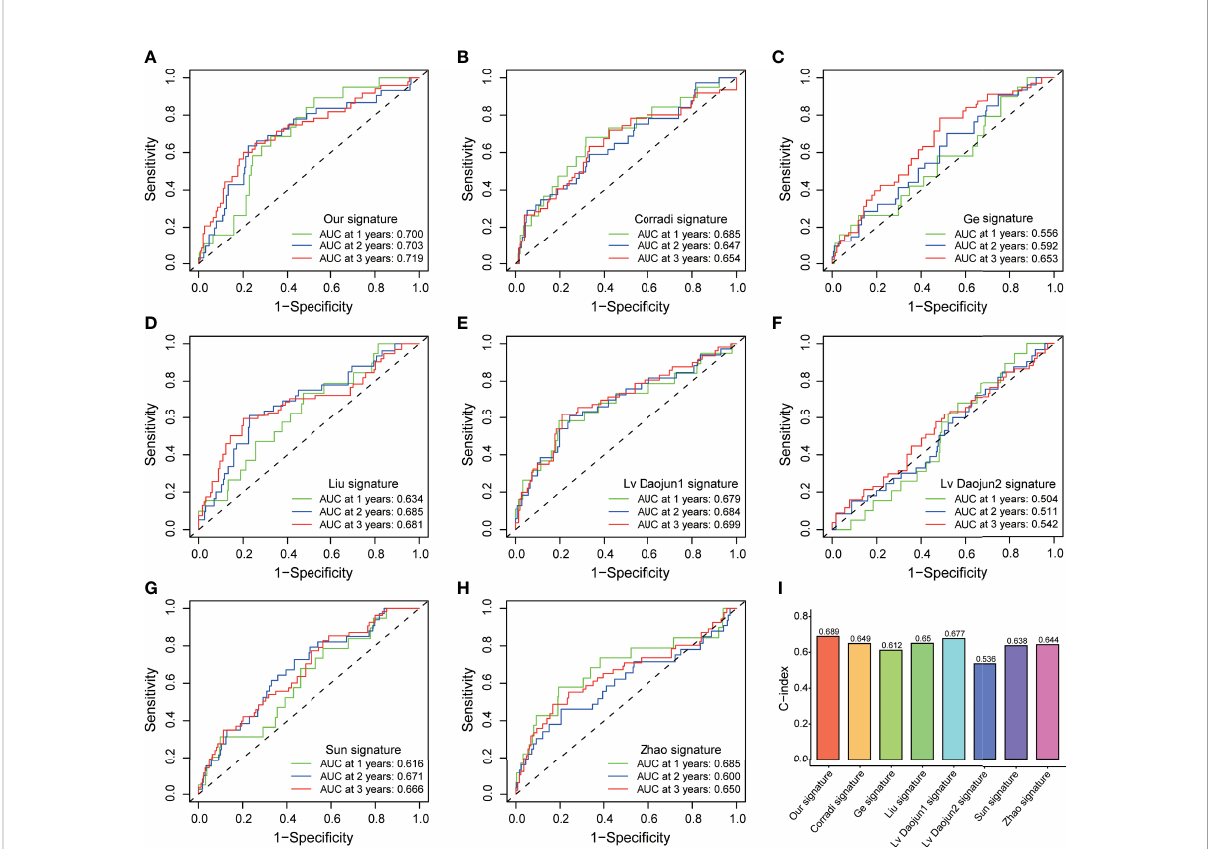
FIGURE 7 External model comparison analysis. (A-H) The ROC analysis curves and (I) C-index of the signature and multiple external